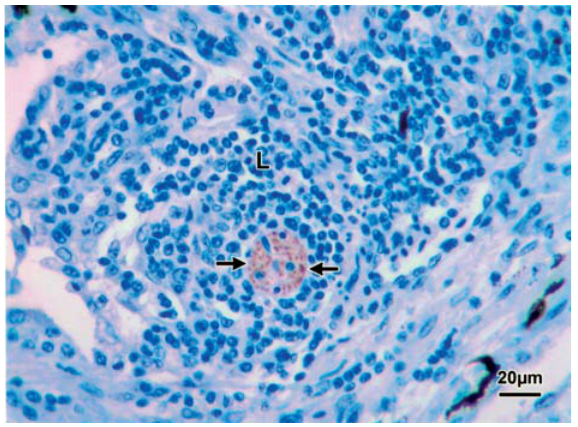
FIG. 2 NP immunoreactive nerve bundle (arrows) surrounded by lymphocytes (L)